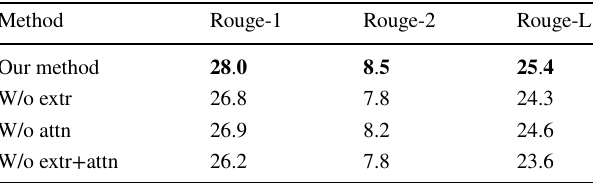
Table 5 Performance comparison of various abstractive models on the DailyMail test set using limited length recall variants of Rouge at 75